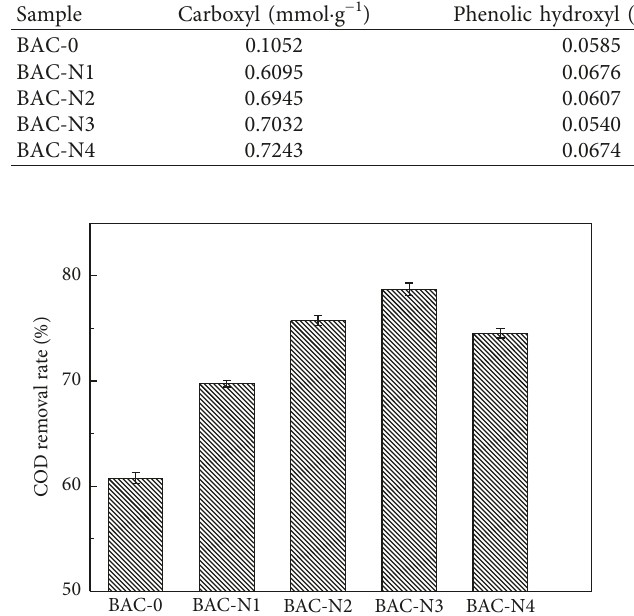
Figure 3: Effects of modification condition of BAC on the COD removal rate (the error bars indicate standard deviation of the mean of three sets of